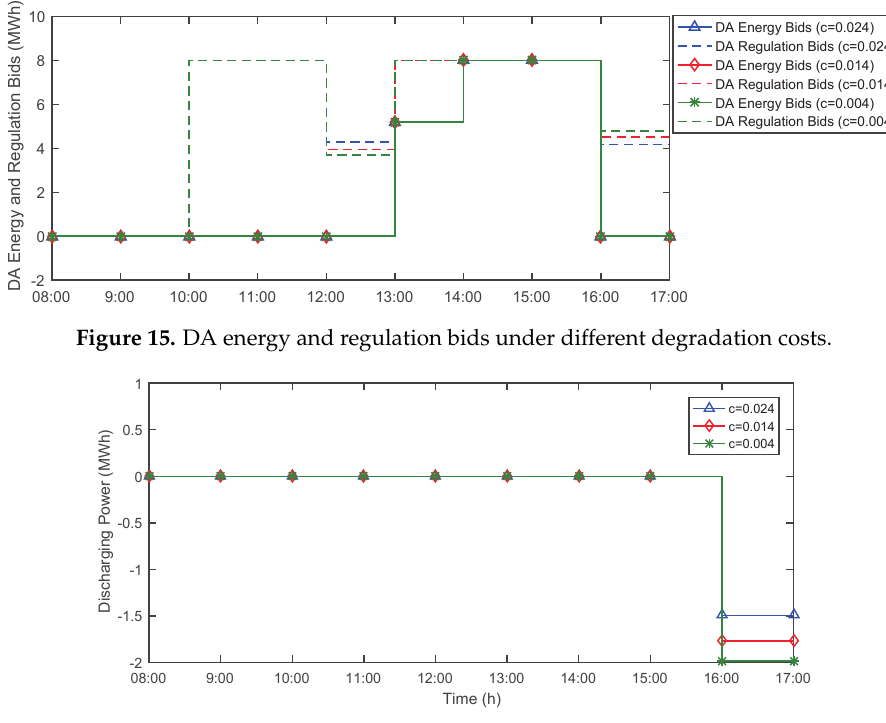
Figure 16. Discharging power of PEVs under different degradation